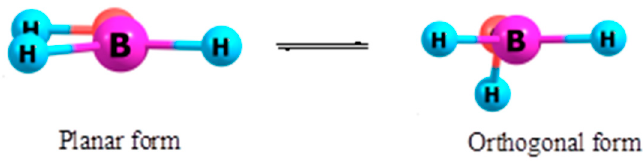
Figure 7. Conformational equilibrium of hydroxyborane. Adapted with modification [171].